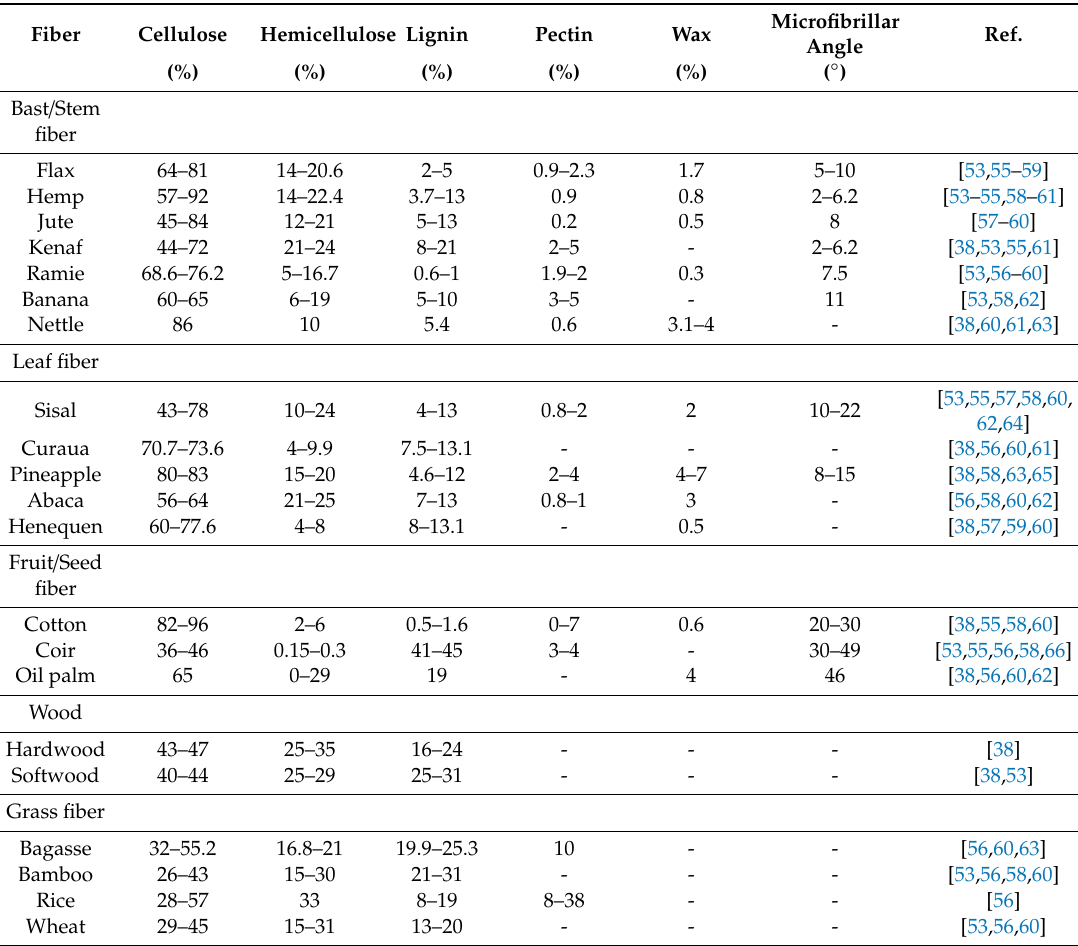
Table 1. Chemical composition of various natural